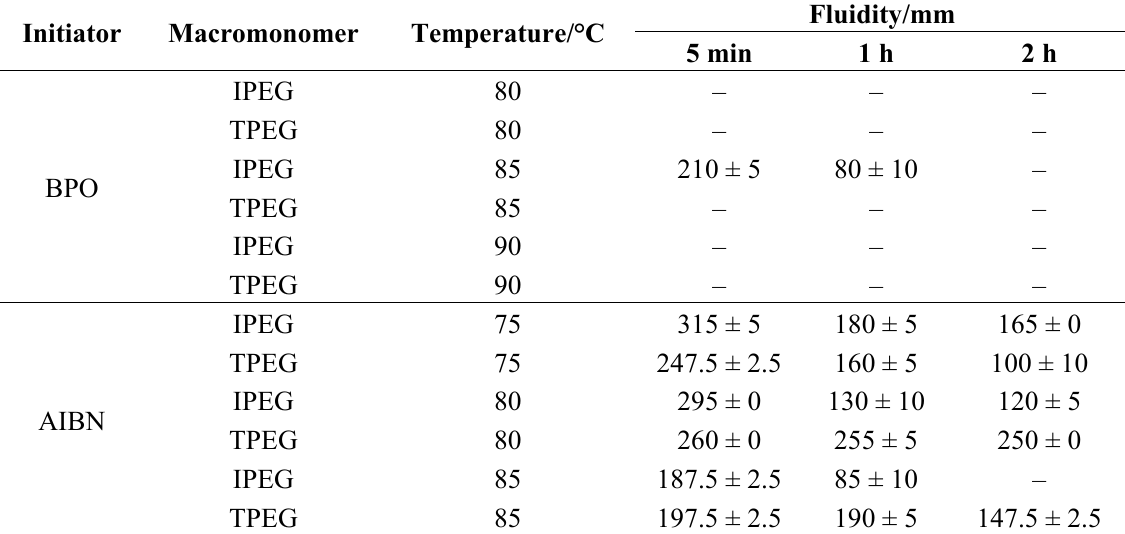
Table 2. Fluidities of cement pastes for PCEs synthesized at different conditions (PCE samples: purified; PCE dosage: 0.2% bwoc (by weight of cement)). BPO, benzoyl peroxide; AIBN,